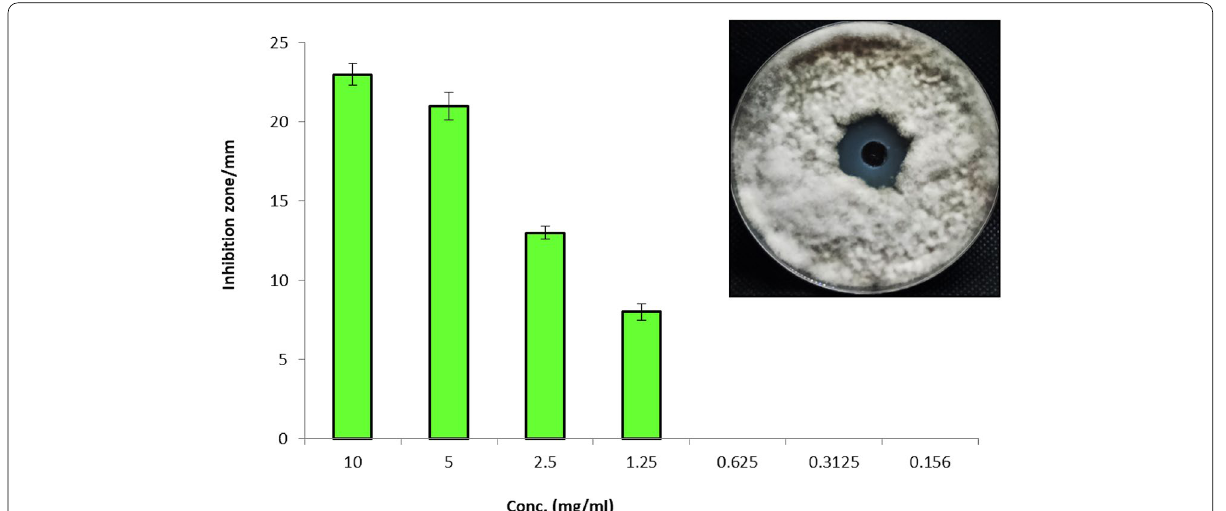
Fig. 2 Antifungal activity of A. terreus against A. solani invitro efficacy of A. terreus on A. solani early blight disease of S. melongena under pots conditions